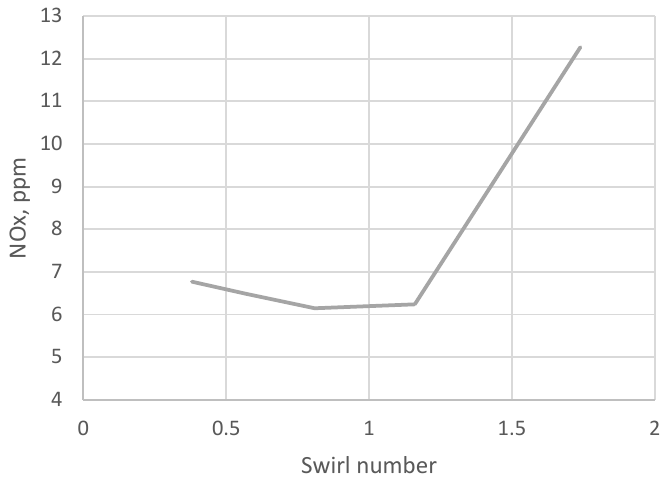
Figure 11. Nitrogen oxide (NOx) at outlet gas versus swirl number of the inlet air.